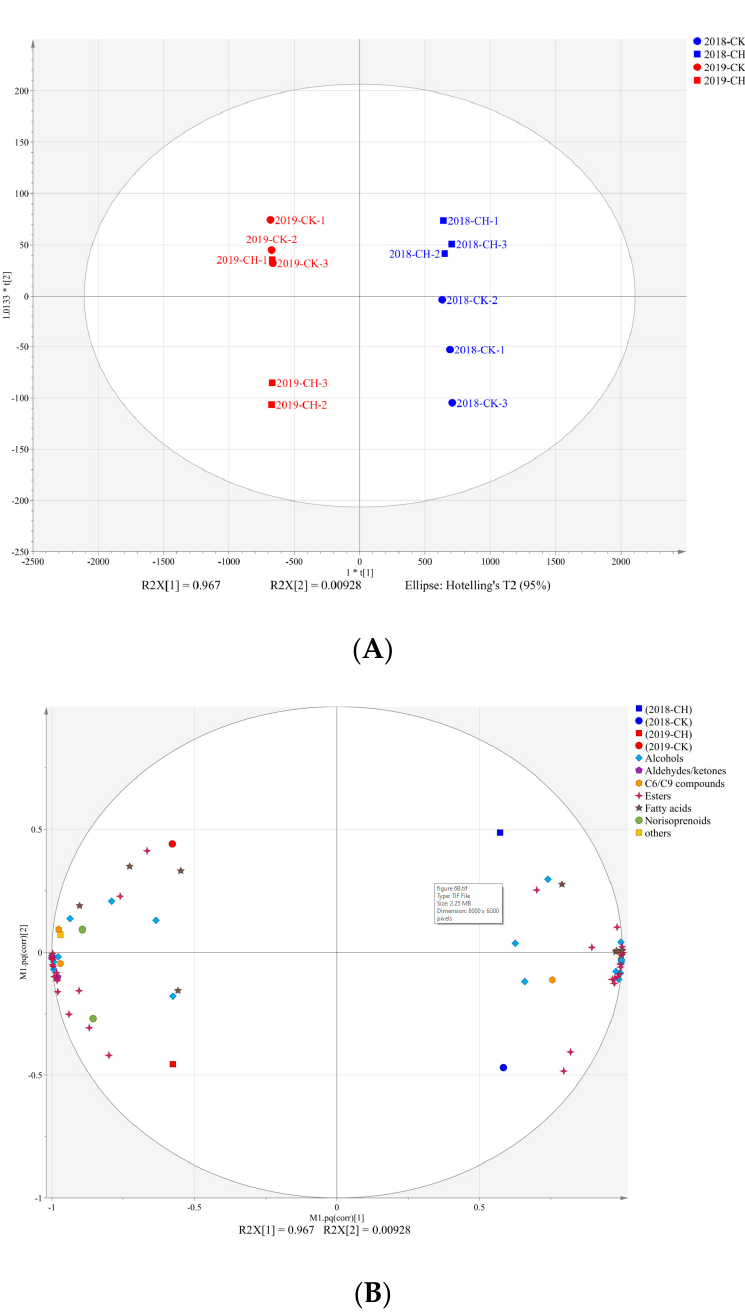
Figure 6. OPLS-DA analysis based on the aroma compounds in the wines of CK and CH in 2018 and 2019. ( A ) score scatter plot, ( B ) correlation loading plot